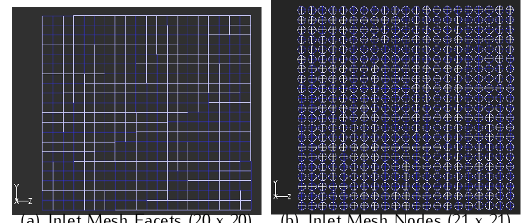
Figure 10. Computational water inlet channel mesh (mirrored at symmetry